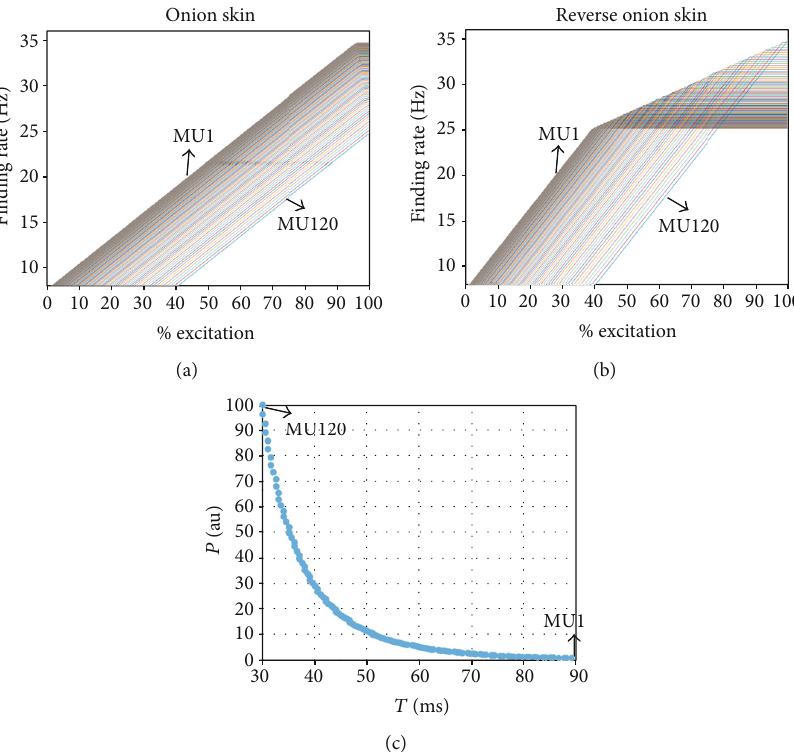
Figure 1: (a) The simulated relation between the excitation level and the motor unit fi ring rate for the “ onion skin ” fi ring strategy. (b) The simulated relation between the excitation level and the motor unit fi ring rate for the reverse “ onion skin ” fi ring strategy. (c) The twitch parameter assignment for the entire pool of 120 motor